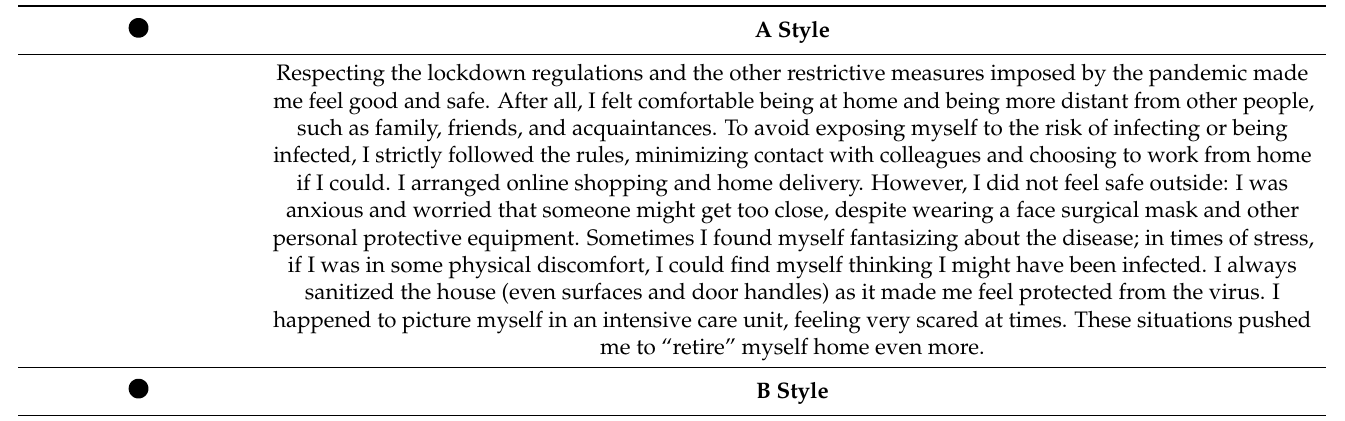
Table A1. Description of four different styles of response to the pandemic and its related restrictive